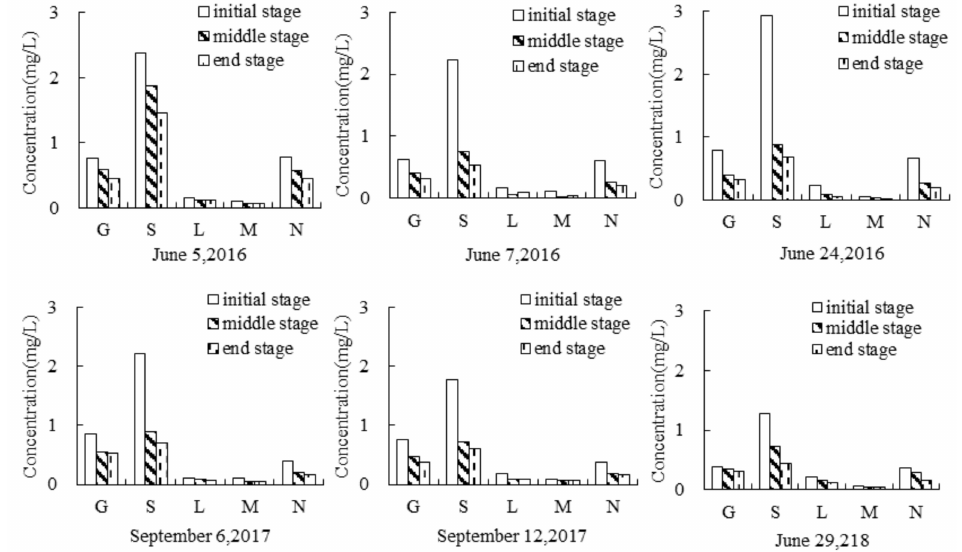
Figure 9. Observed total phosphate concentration of the subsurface drainage